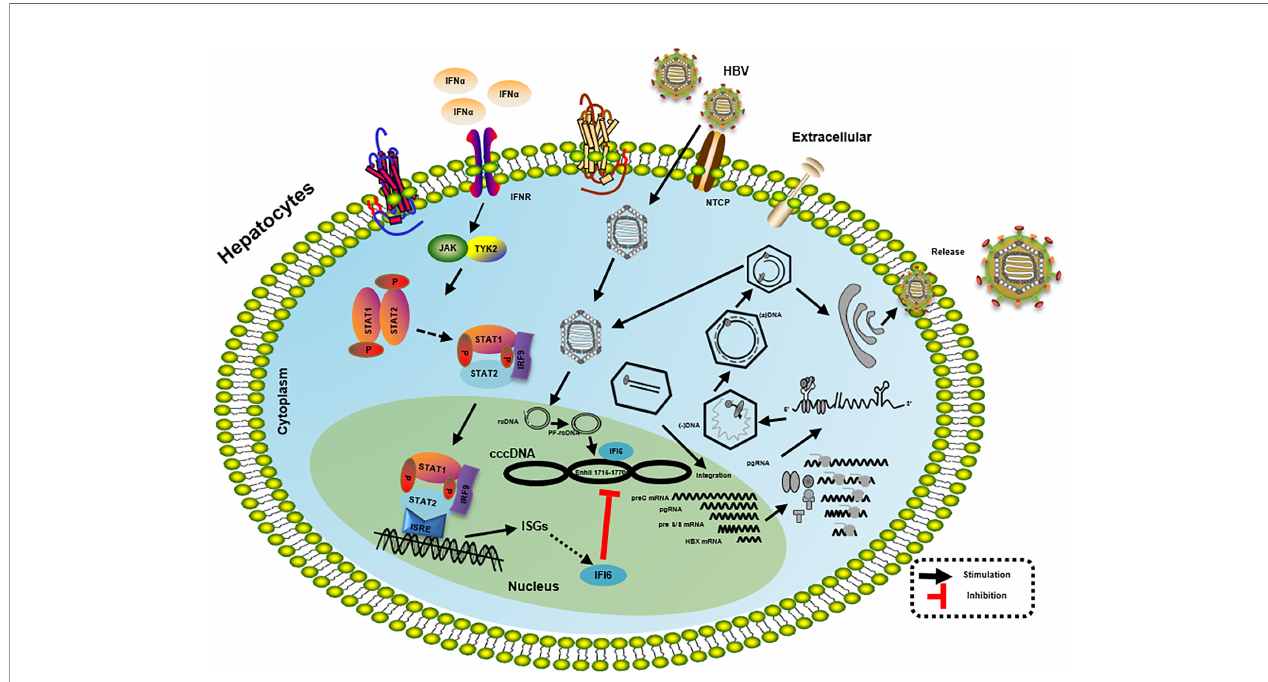
FIGURE 7 | Mechanism of IFI6 mediated inhibition of HBV replication and gene expression. The type I IFN binds to the cell receptor and induces the JAK-STAT signaling pathway that subsequently induces transcription of ISGs. IFI6 is one of the IFN-stimulated genes that inhibit the transcription of 3.5 kb, 2.4 kb, and 2.1 kb RNA of HBV that subsequently inhibit the translation of different HBV